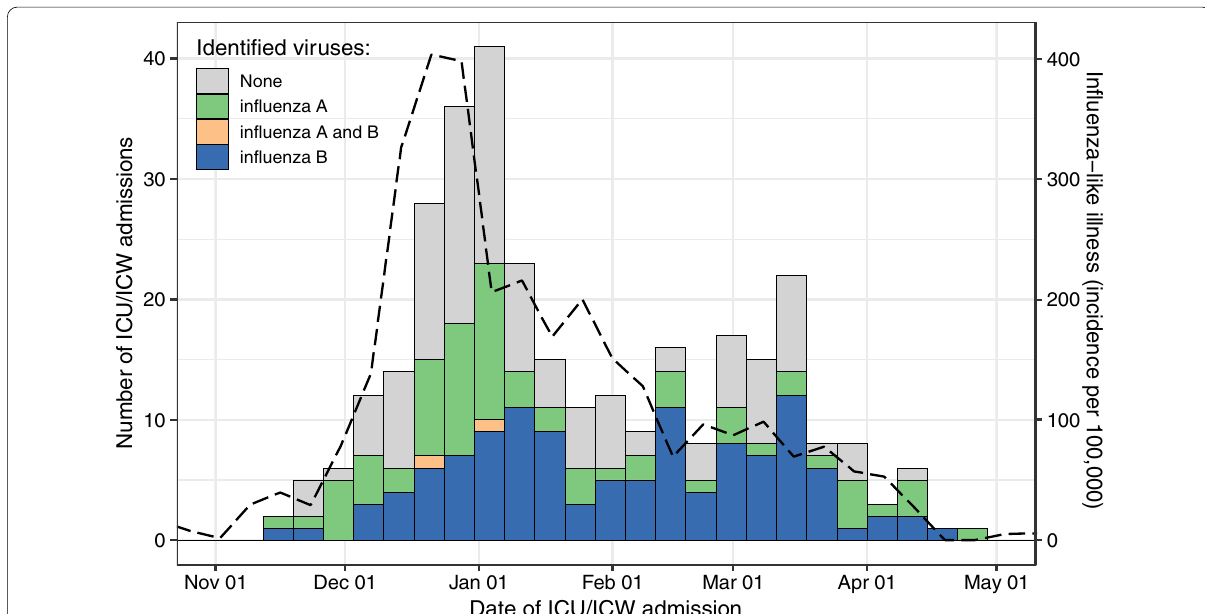
Fig. 1 ICU/ICW admissions throughout the 2017–2018 influenza season according to virus type. ICU/ICW weekly admissions in ICU/ICW, according to identified influenza virus types (bar plot, left axis) and incidence of influenza-like illness in Paris area (dashed line, right axis) [reference: https://